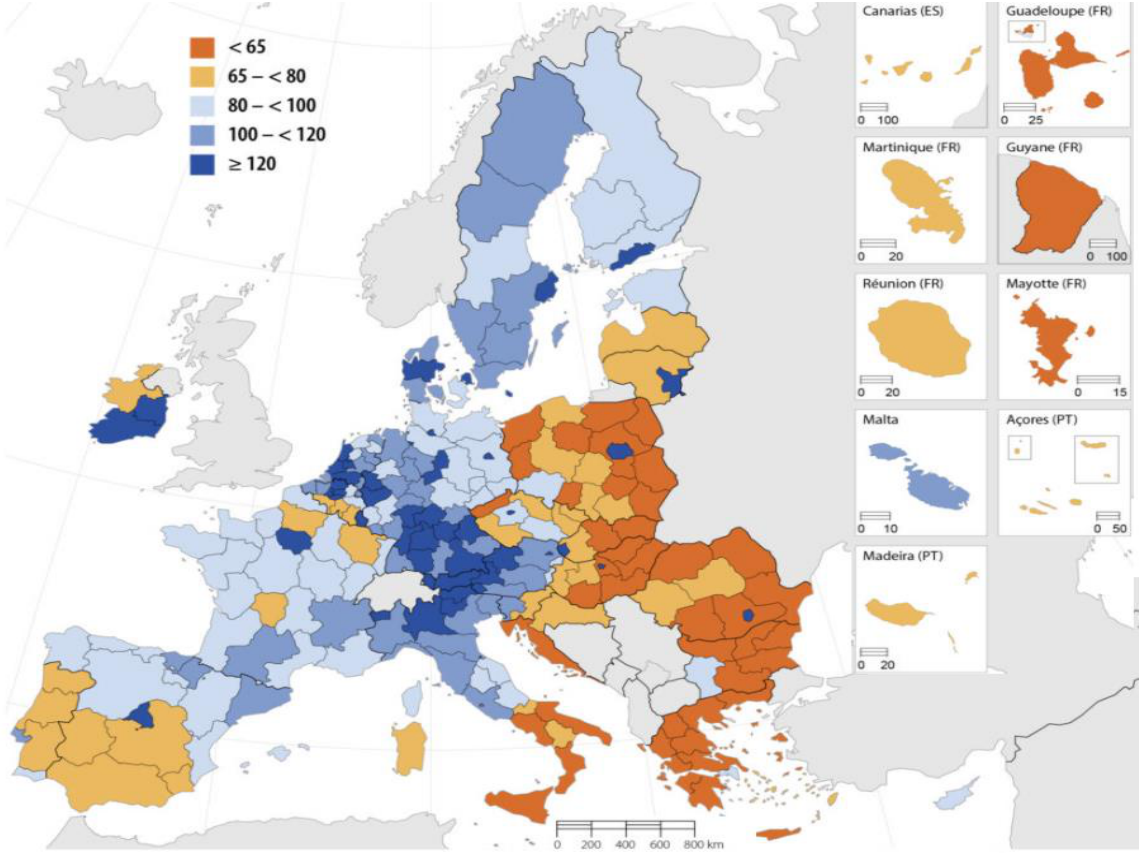
Figure 1. GDP/capita in EU regions (NUTS 2), 2019 (in PPS, EU = 100). Source: (Eurostat 2021).